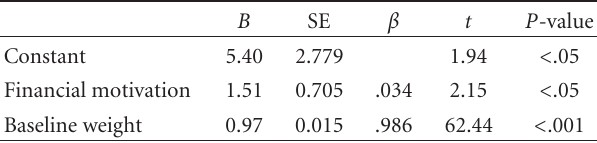
Table 1: Regression model predicting weight at the end of follow- up (maintenance).